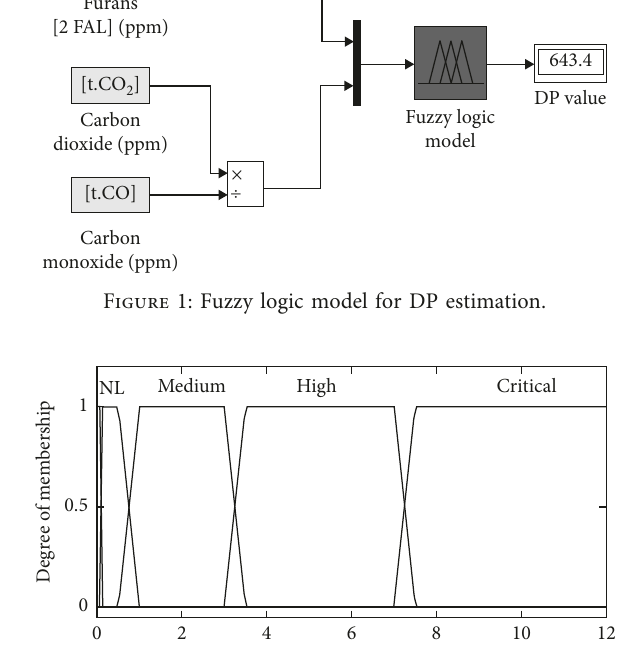
Figure 2: Input parameter membership function-furans (2-FAL) (ppm).